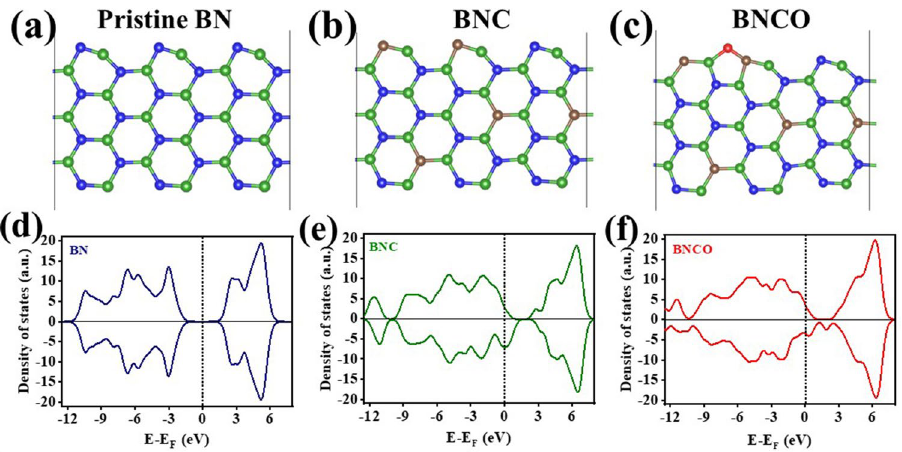
Fig. 1 Optimised model structures of a BN, b BNC, and c BNCO systems. The N, C, O, B atoms are denoted with blue, wine, red, green colour spheres, respectively . Plot of Density of States for d BN, e BNC, f BNCO systems. The vertical dotted line at zero represents the Fermi